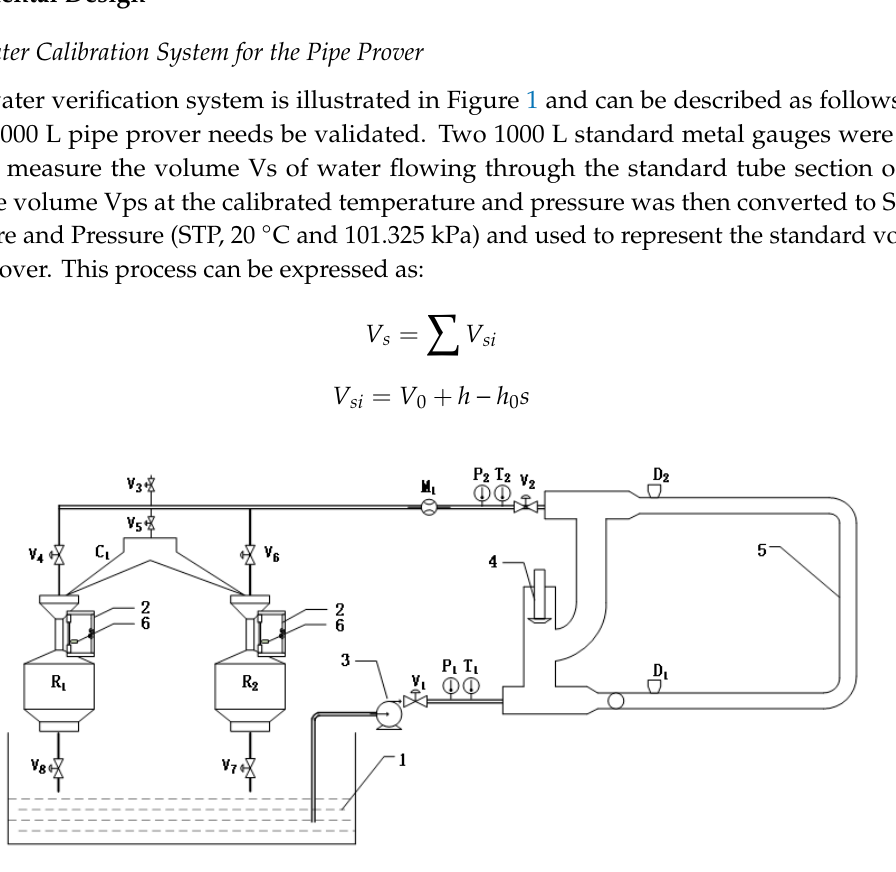
Figure 1. A schematic diagram of the water calibration system used in the pipe prover. Labels include: 1—pool, 2—liquid level collection system, 3—pump, 4—ball push device, 5—volume tube, 6—infrared photoelectric detection switch, (V1–V8)—solenoid valves, (D1 and D2)—detection switches, (P1